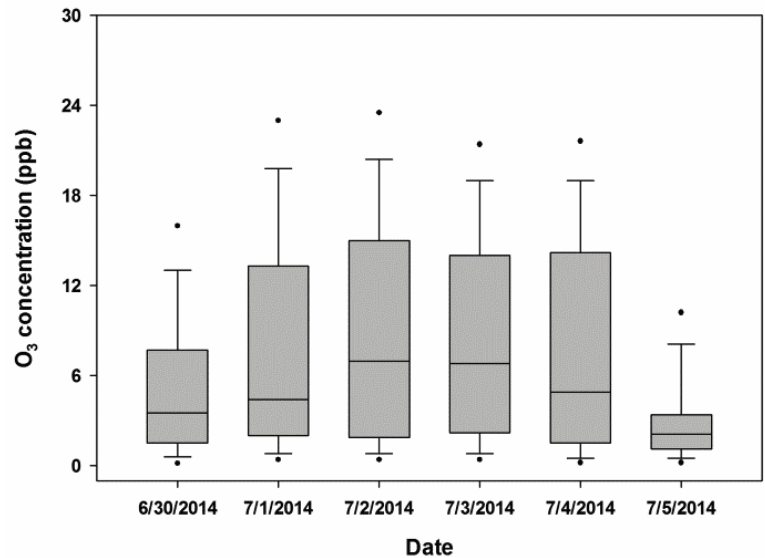
Figure 3. Distribution of O 3 concentrations (1-min average) measured at the central monitoring site in